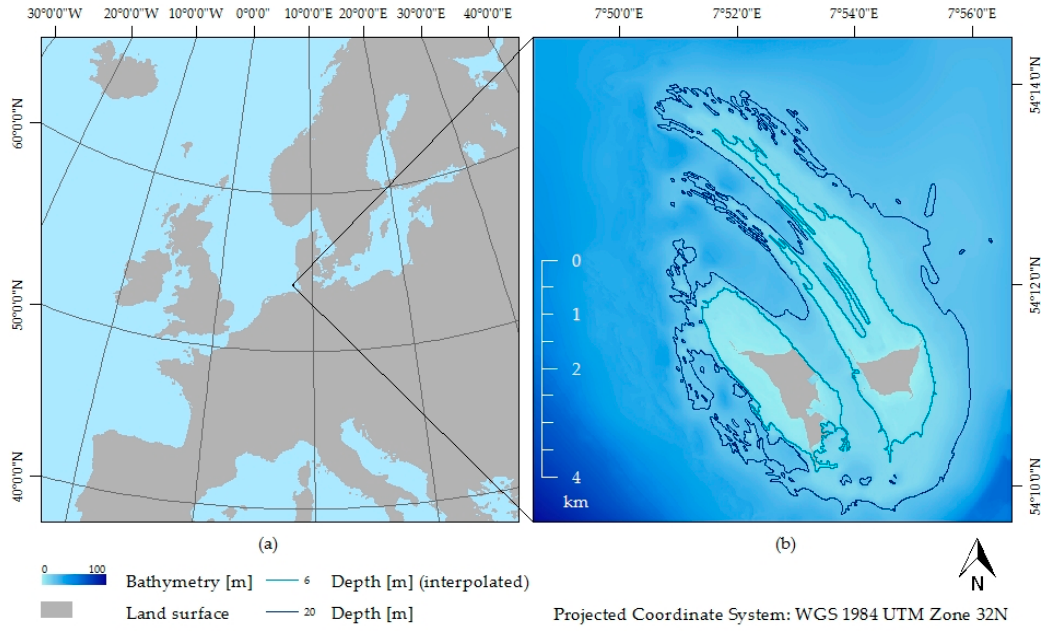
Figure 1. ( a ) The location of Helgoland is outlined in a map of Europe (data source: openstreetmapdata.com); ( b ) A bathymetric map based on sea chart level zero (lowest astronomical tide) of the subtidal zone of the archipelago (data source: courtesy of Federal Maritime and Hydrographic Agency of Germany 2010).